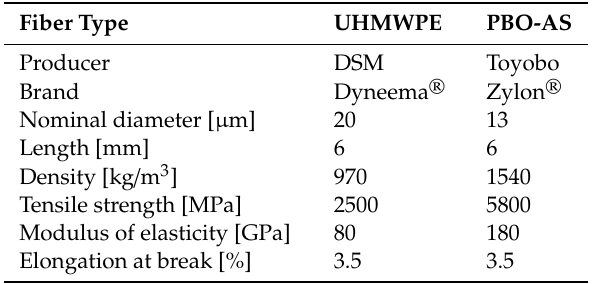
Table 2. Properties of polymer fibers as provided by the producers [25,26].